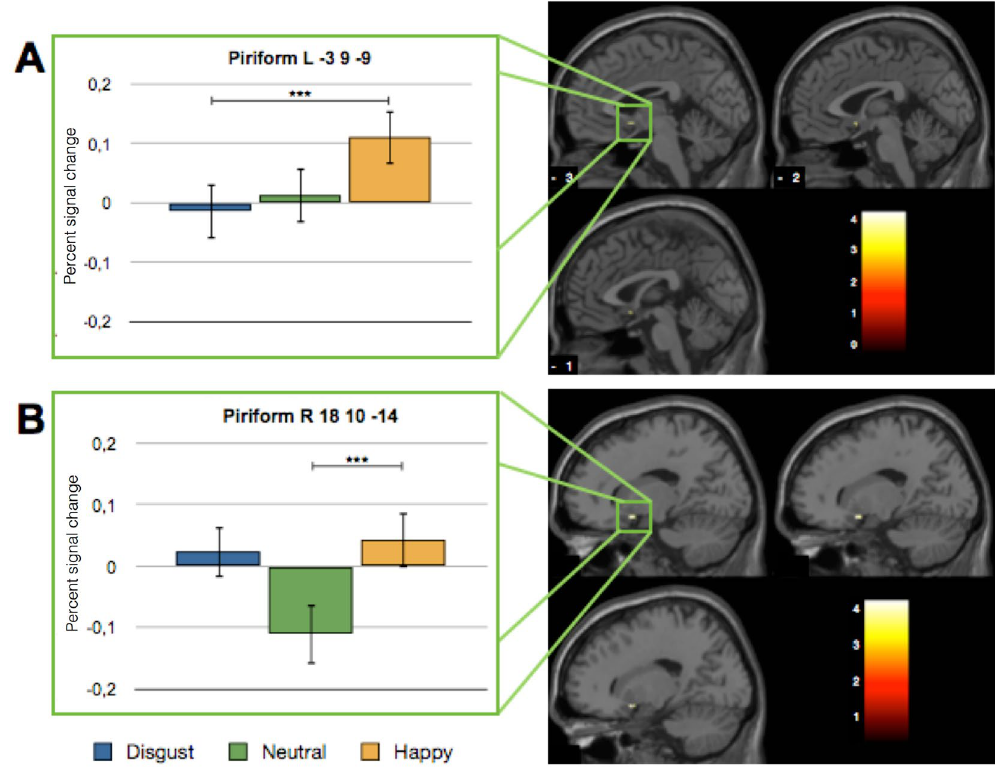
Figure 3. Increased piriform cortex activation prior to odor perception. ( A ) Increased activation for happy faces compared to disgusted faces can be shown within the left piriform Cortex (Piriform L). ( B ) Increased activation for happy faces compared to neutral faces can be shown within the right piriform Cortex (Piriform R). Percent signal change within the small volume corrected ROI (bilateral primary olfactory Cortex) is shown in bar graph: *** signifies a statistically significant difference at the threshold 0.001 corresponding to a FWE- Corrected threshold for small volume of 0.05.